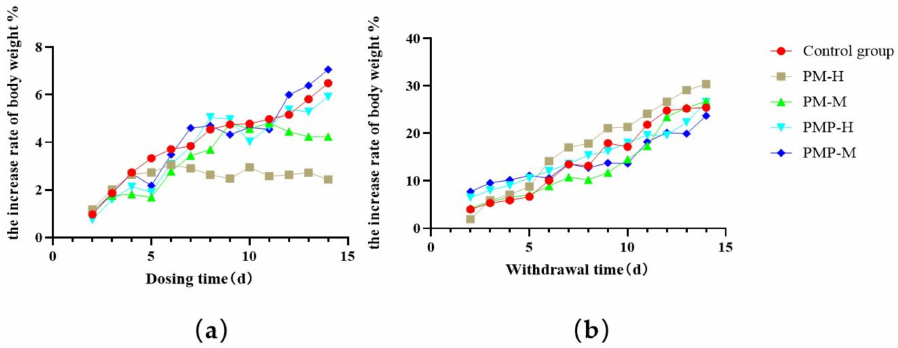
Figure 2. The increase in body weight in rats: during administration ( a ); during drug withdrawal ( b